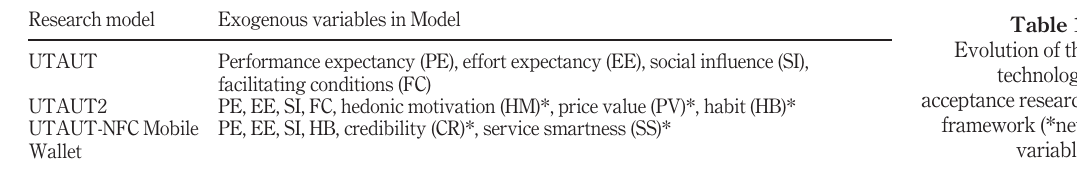
Table 1. Evolution of